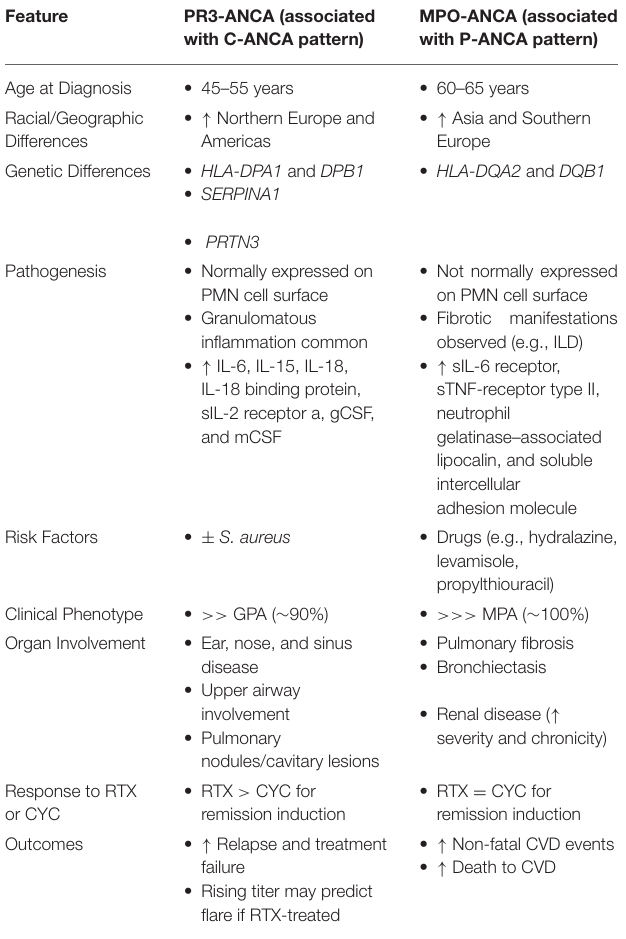
TABLE 1 | Distinguishing features between PR3-ANCA + and MPO-ANCA + AAV.